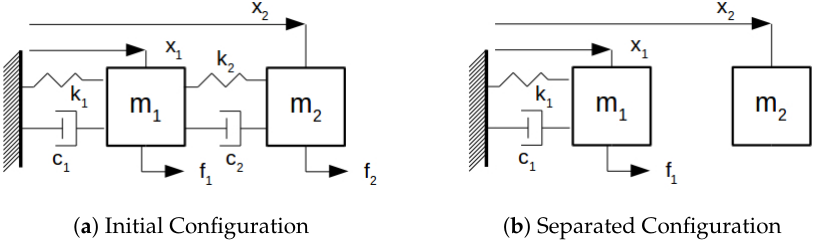
Figure 1. A 2-DOF mass-spring-damper system before ( a ) and after ( b ) the separation of the second mass. Table 1. Store Separation Verification Parameters.